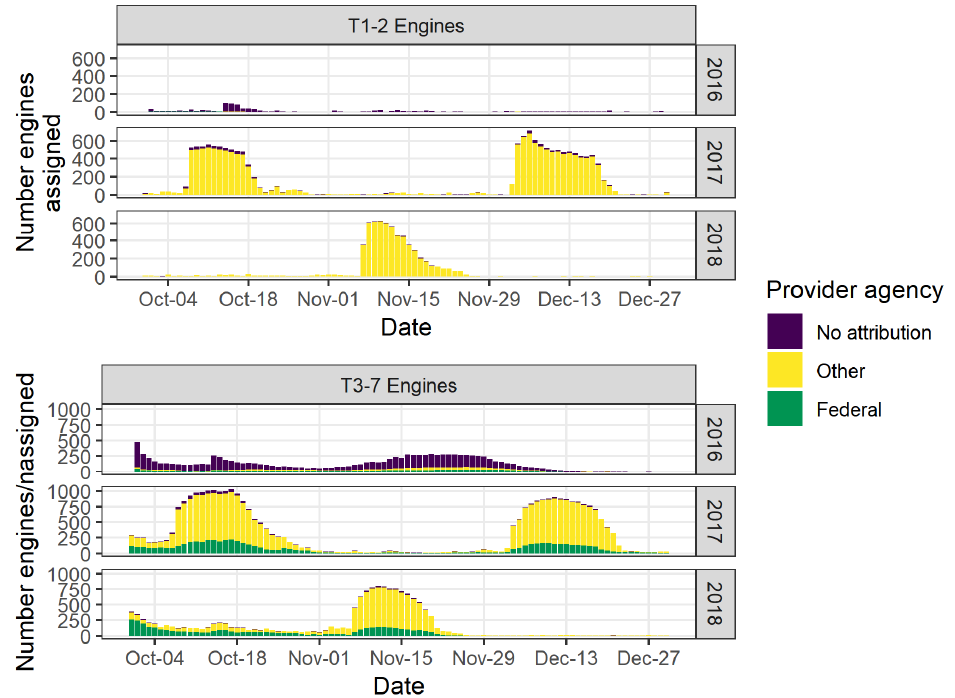
Figure 6. The daily number of structure (T1–T2) and wildland (T3–T7) engines assigned to wildland fires in the United States between 1 October and 31 December in 2016, 2017, and